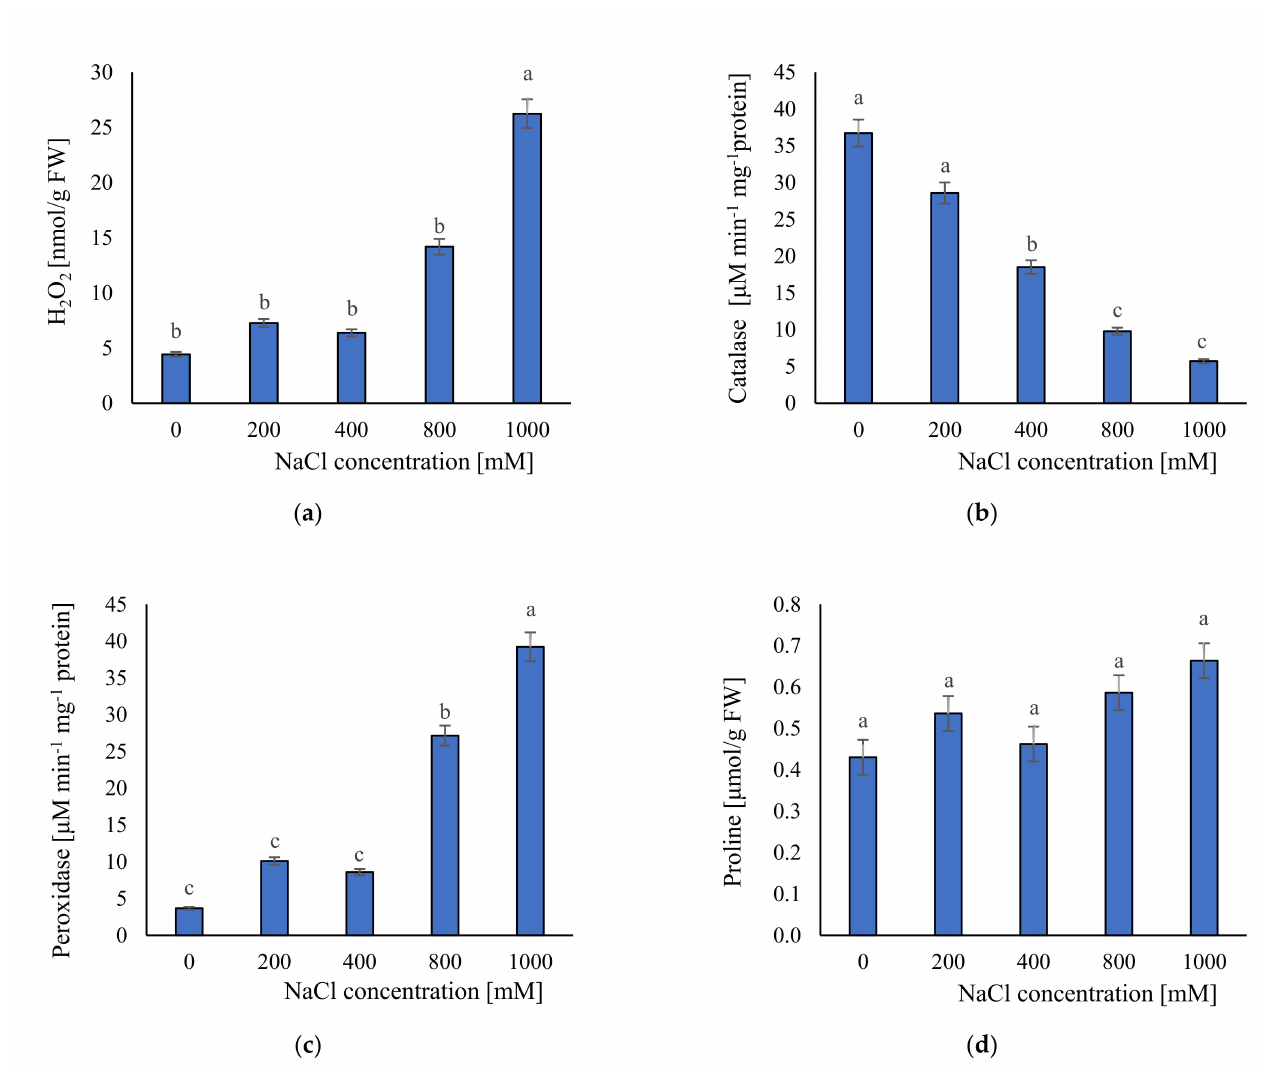
Figure 7. The average parameters of: ( a ) H 2 O 2 content; ( b ) catalase activity; ( c ) peroxidase activity; and ( d ) proline content in the tested plants; ± SD in the tested samples. ANOVA p < 0.001, significant differences based on post hoc Tukey’s test are marked with different